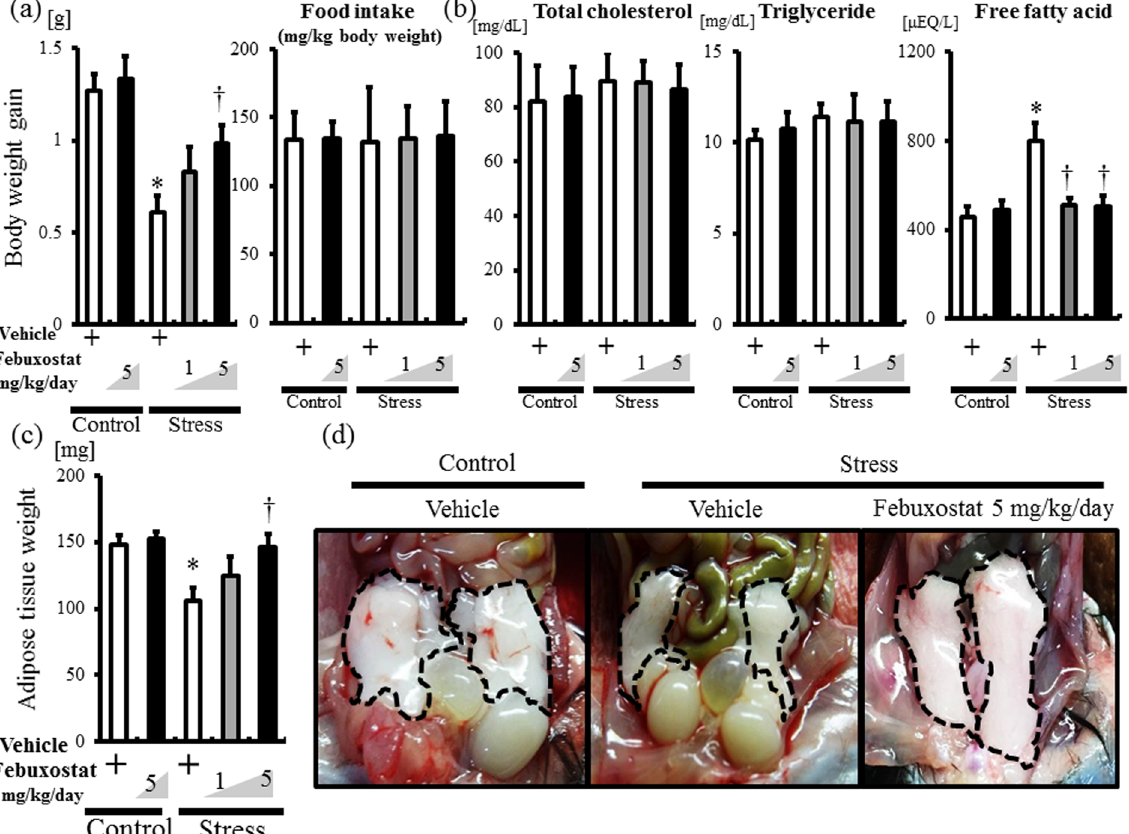
Figure 6. Febuxostat reduces lipolysis and free fatty acid release in stressed mice. Body weight and food intake was monitored during the stress period. At the end of the stress study, inguinal adipose tissue of each group was photographed, weighed and harvested for analysis. Data were analyzed by Student’s t-test and displayed as mean ± SD of 5–6 mice per group. ( a ) Body weight gain in control mice treated with or without febuxostat (5 mg/kg/day) and stressed mice treated with or without febuxostat (1 or 5 mg/kg/day). * P < 0.001, compared with the vehicle-treated control mice, † P < 0.02, compared with the vehicle-treated stressed mice. Food intake was comparable among the groups. ( b ) Plasma fat composition in the control mice treated with or without febuxostat (5 mg/kg/day) and stressed mice treated with or without febuxostat (1 or 5 mg/kg/day). Plasma levels of total cholesterol and triglyceride were comparable among the groups. Plasma free fatty acid levels. * P < 0.002, compared with the vehicle-treated control mice, † P < 0.005, compared with the vehicle-treated stressed mice. ( c ) Weight of inguinal adipose tissue in control mice treated with or without febuxostat (5 mg/kg/day) and stressed mice treated with or without febuxostat (1 or 5 mg/kg/day). * P < 0.003, compared with the vehicle- treated control mice, † P < 0.008 compared with the vehicle-treated stressed mice. ( d ) Representative pictures of inguinal fat pad in control (non-treated), stressed and febuxostat (5 mg/kg/day) treated mice. Circle dot line: adipose